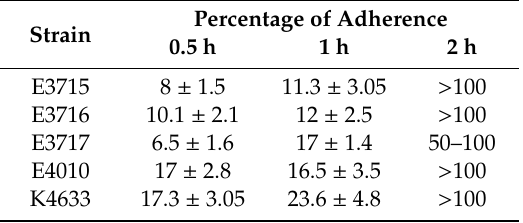
Table 1. Adherence ability among different strains of V. vulnificus.